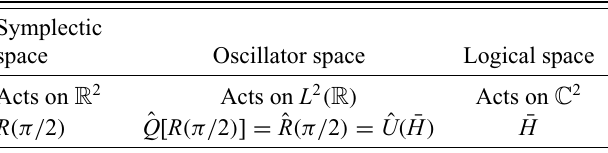
TABLE I. Example of different representations for a logical Hadamard gate in the single-mode square GKP code, imple- mented by a rotation by π/ 2 in phase space. In general, symplec- tic matrices act on the real vector space R 2 m , quantum unitaries act on the set of square integrable functions L 2 ( R m ) and logical operations act on a qubit Hilbert space C 2